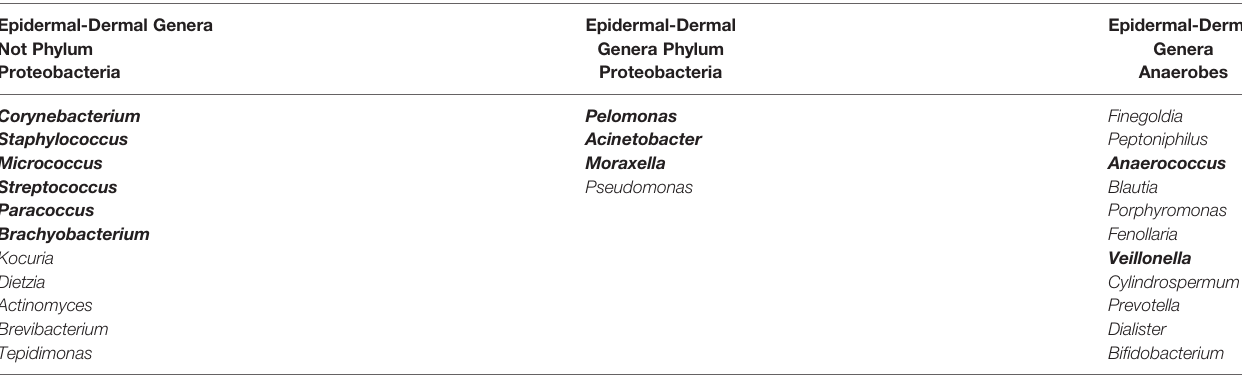
TABLE 1 | Bacterial microbiota in the epidermal and dermal